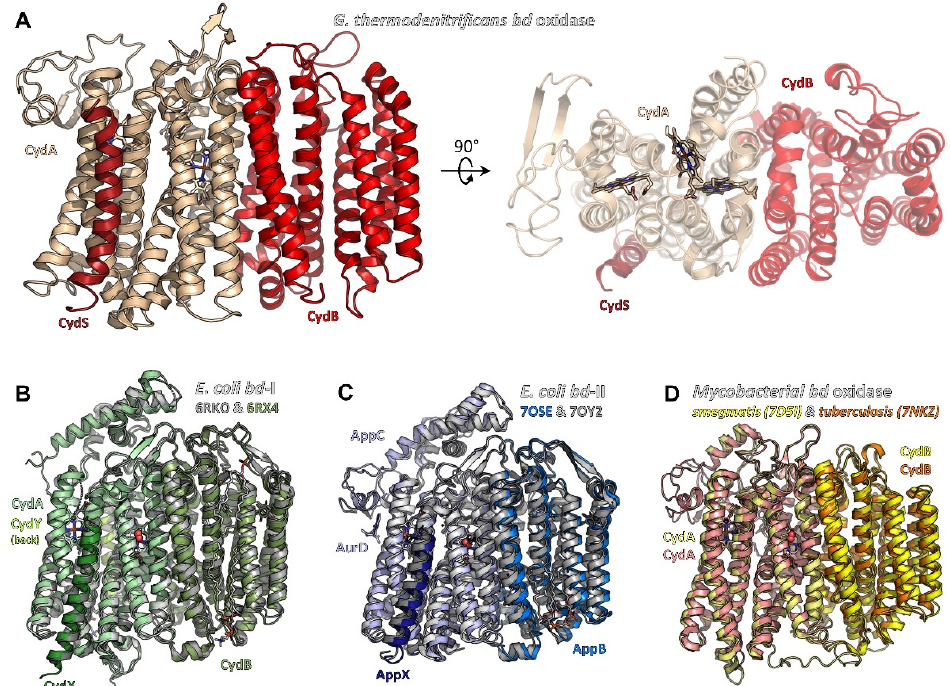
Figure 1. Structures of bacterial cytochrome bd oxidases. ( A ) bd oxidase of G. thermodenitrificans (pdb ID 5DOQ) is composed of subunits CydA (light beige), CydB (red), and CydS (dark red). The heme groups are located in subunit CydA. ( B ) E. coli bd ‐ I (pdb ID 6RKO in grey tones, pdb ID 6RXO in green colours) comprises four subunits, termed CydA, CydB, CydX, and CydY. While CydA, CydB, and CydX have homologues in G. thermodenitrificans , CydY is exclusive for E. coli bd ‐ I. ( C ) bd ‐ II oxidase from E. coli (pdb ID 7OSE in blue colours, pdb ID 7OY2 in grey tones) is built by subunits AppC (homologue to CydA), AppB (homologue to CydB), and AppX (homologous to CydS/X). 7OSE has been solved with the inhibitor aurachin D (AurD) bound to the Q ‐ loop. ( D ) The mycobacterial bd oxidase ( M. smegmatis , pdb ID 7D5I, in yellow colours, M. tuberculosis , pdb ID 7NKZ, in orange and salmon) consists of only two subunits, CydA and CydB.